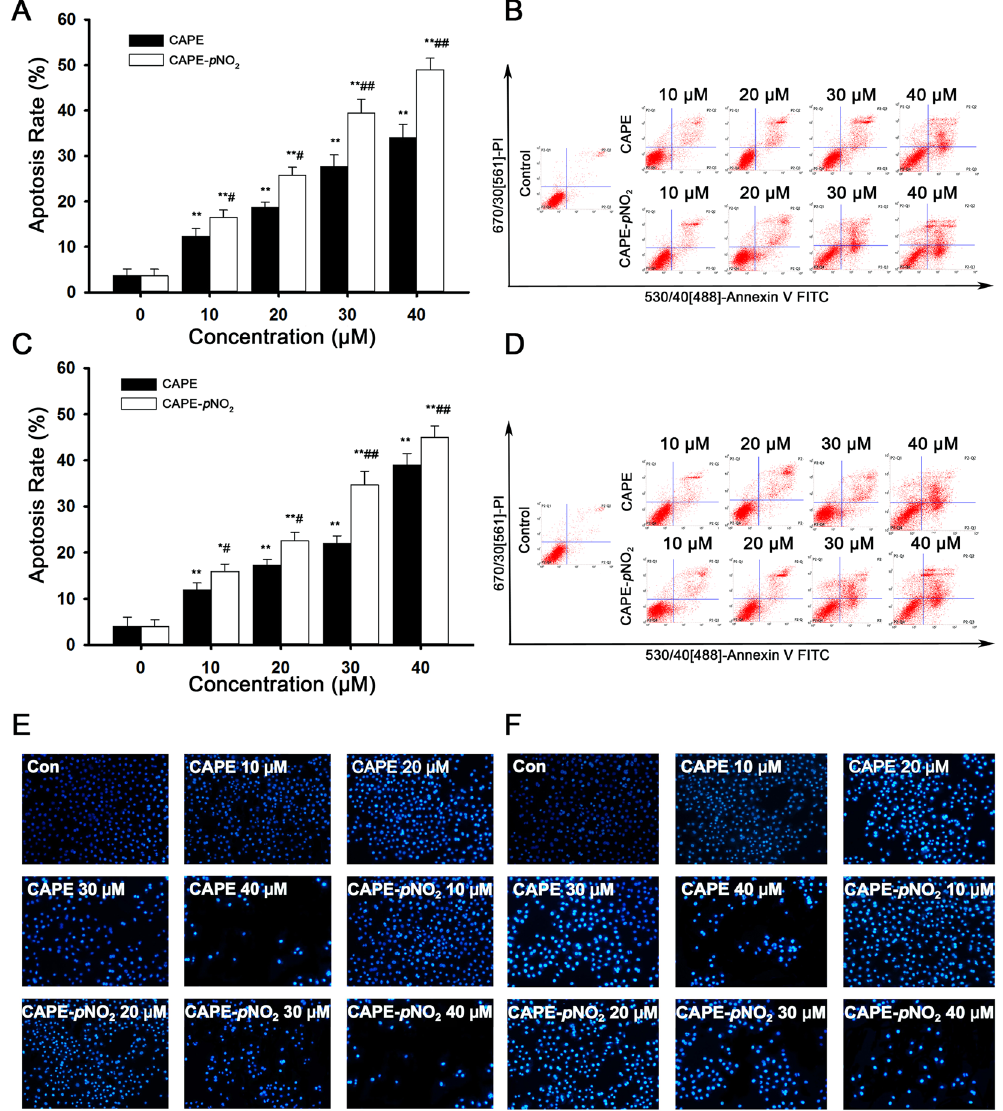
Figure 2. CAPE and CAPE- p NO 2 induce apoptosis in colon cancer cells. HT-29 and HCT-116 cells were treated with 0, 10, 20, 30 and 40 μ mol/L CAPE and CAPE- p NO 2 for 48 h. The apoptosis rates of HT-29 cells (A) and HCT-116 cells (B) were calculated by SigmaPlot 12.5. Flow cytometry analysis in HT-29 (C) and HCT- 116 (D) cells. HT-29 cells (E) and HCT-116 (F) cells ( × 200) were stained by Hoechst 33342 after treatment with different concentrations of CAPE and CAPE- p NO 2 for 48 h. From the microscopic vision fields, the cell number was decreased, and fluorescence was increased by treatment for 48 h in a dose-dependent manner. Values represented the means ± SD from three independent experiments, and error bars represented the STDEV (SD). * p < 0.05, ** p < 0.01: CAPE and CAPE- p NO 2 compared with the control. # p < 0.05, ## p < 0.01: CAPE- p NO 2 compared with CAPE at the same CAPE and CAPE- p NO induce cell cycle arrest in G0/G1 in colon cancer cells. The cell cycle dis- 2 tribution was detected by flow cytometry. As shown in Fig. 3, the number of HT-29 cells (Fig. 3A) in G0/G1 phase increased in a dose-dependent manner from 31.9% to 77.3% and 86.5% after treatment with CAPE and CAPE- p NO 2 , respectively. Concerning HCT-116 cells (Fig. 3B), the G0/G1 phase increased from 31.0% to 80.1% and 84.5%, but the G2/M phase was barely changed in the present study. The results proved that the progres- sion of cells from G1 to the S phase was interrupted more obviously by CAPE- p NO 2 than by CAPE ( p < 0.01) (Fig. 3C,D). CAPE and CAPE- p NO regulate the expression of P53 signalling pathway related proteins 2 in HT-29 cell and tumours. The expression of related proteins in HT-29 cells was measured by western blot assay after treatment with CAPE and CAPE- p NO 2 (Fig. 4). The results showed that these two drugs could down-regulate the expression of pro-caspase-3, which was reduced by 44.0% and 79.0% after treatment with